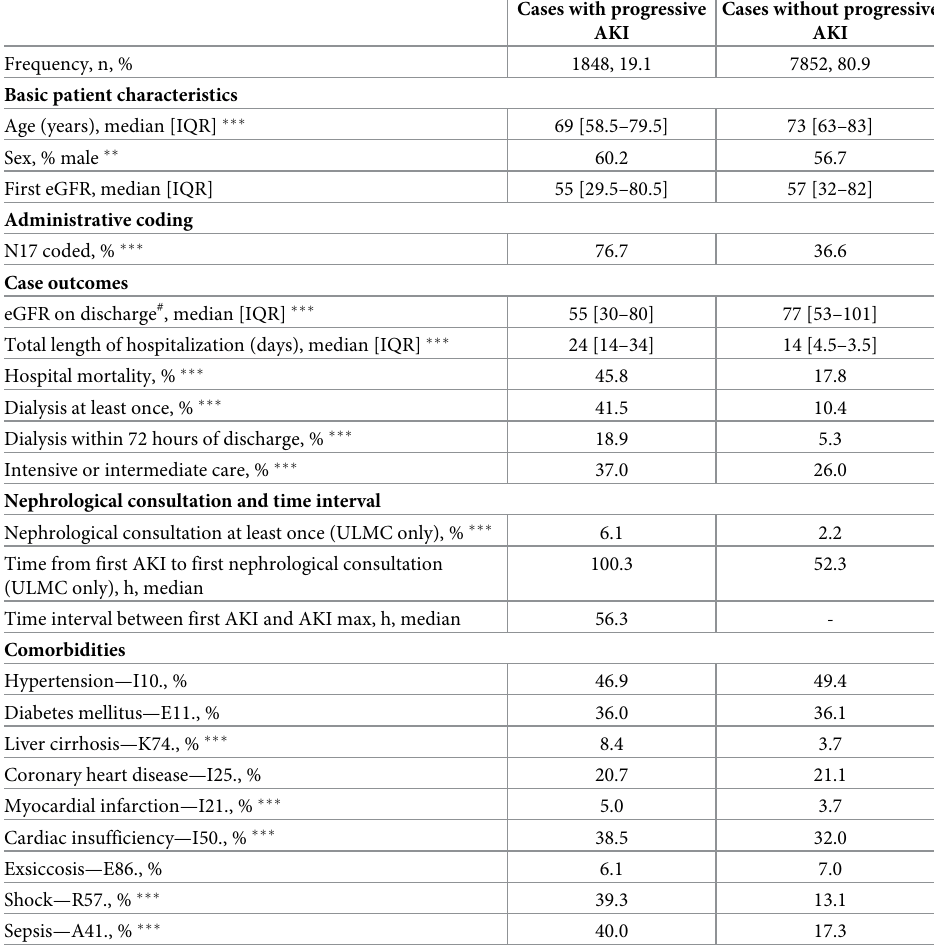
Table 5. Comparison of cases with progressive and non-progressive AKI